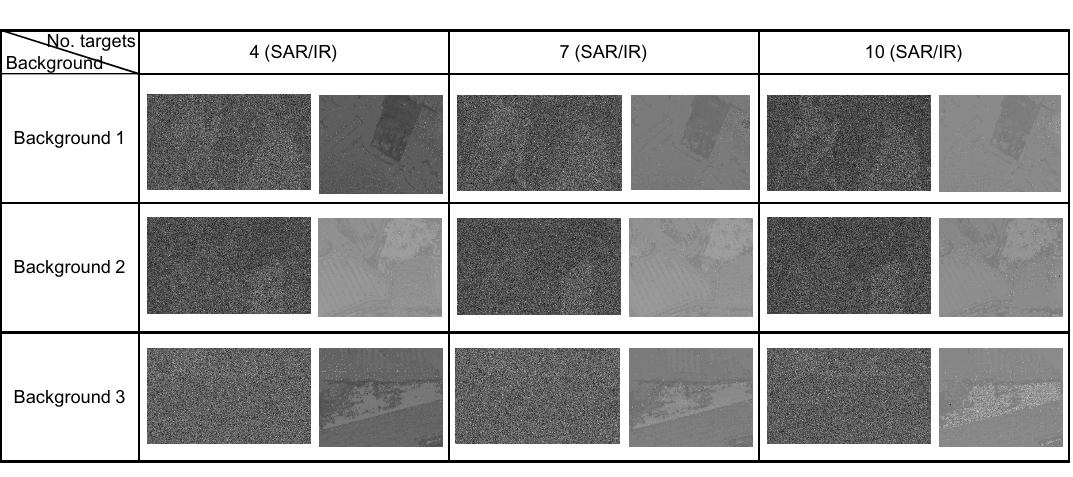
Figure 20. Synthesized SAR and IR database generated by